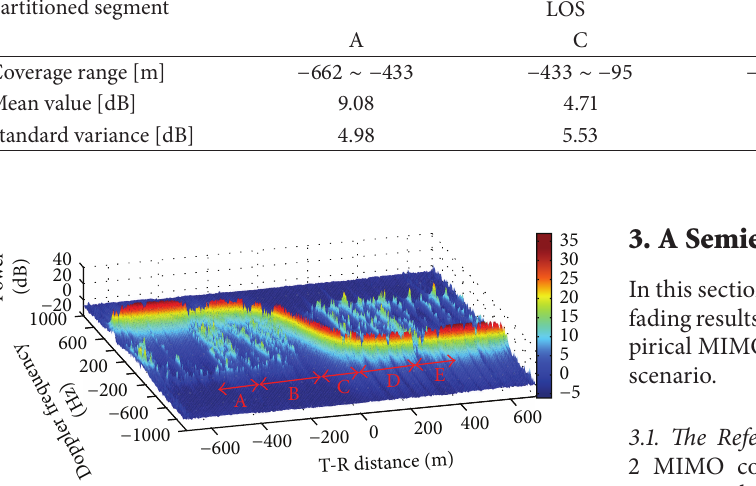
Figure 6: The instantaneous Doppler PSD over T-R distance.